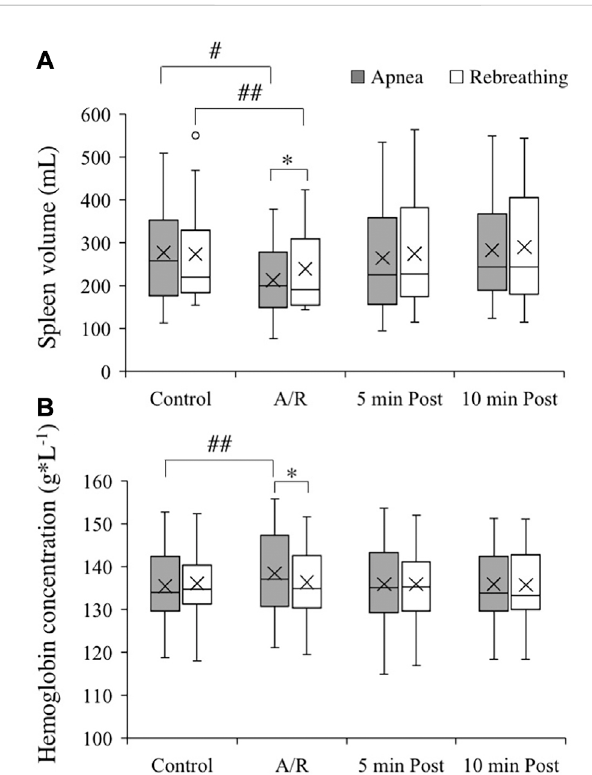
FIGURE 2 Spleen volume [ (A) , n = 13] and hemoglobin concentration of venous blood [ (B) , n = 18] before apneas or rebreathing (Control), during the series of apneas or rebreathing (A/R), and fi ve and 10 min afterterminationofthe fi fthapneaorrebreathing(5 minPostand 10 min Post, respectively). The boxes indicate the fi rst and third quartile of the data with the median (vertical line) and mean (X) values indicated.Thewhiskersindicatethelowestandthehighestdatapoints in the data set, excluding any outliers (circles). * p < 0.05 between apnea and rebreathing. # p < 0.05 and ## p < 0.01 compared with respective control